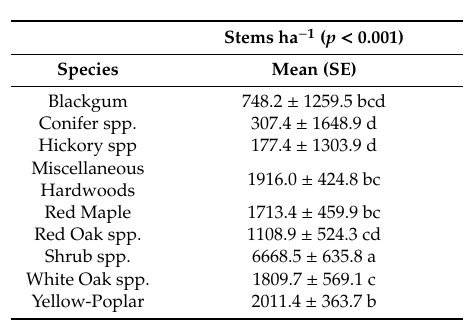
Table 4. Natural regeneration mean, standard error, and letter groupings for species and species class are presented for inside cluster plantings for the five site preparation and release treatments tested in the shortleaf pine–hardwood establishment study, following four growing seasons in Morgan County, Tennessee, USA. Treatment means followed by the same letter in a column indicate no significant di ff erences ( p = 0.05).